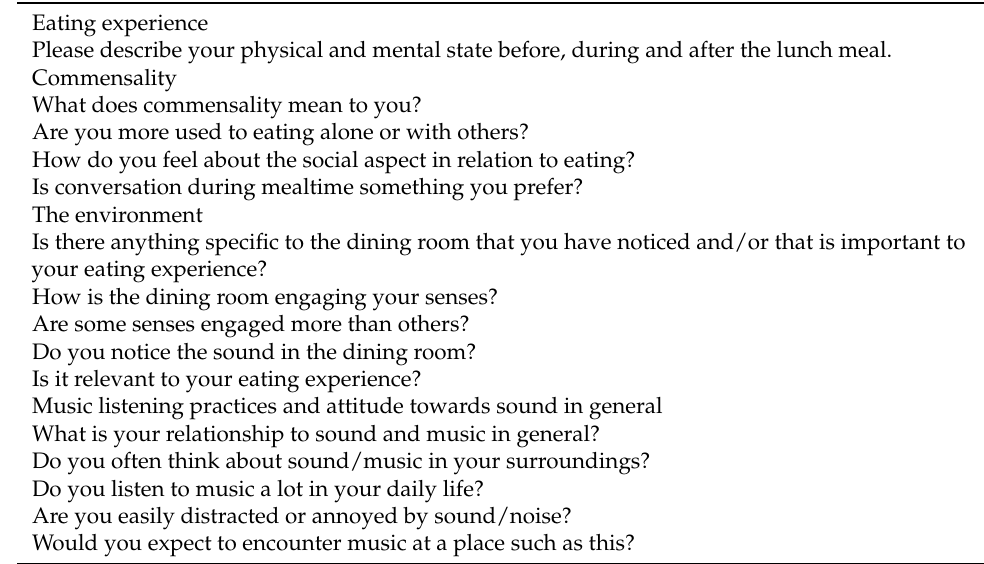
Table A2. Sample themes/questions from the semi structured interviews. Eating